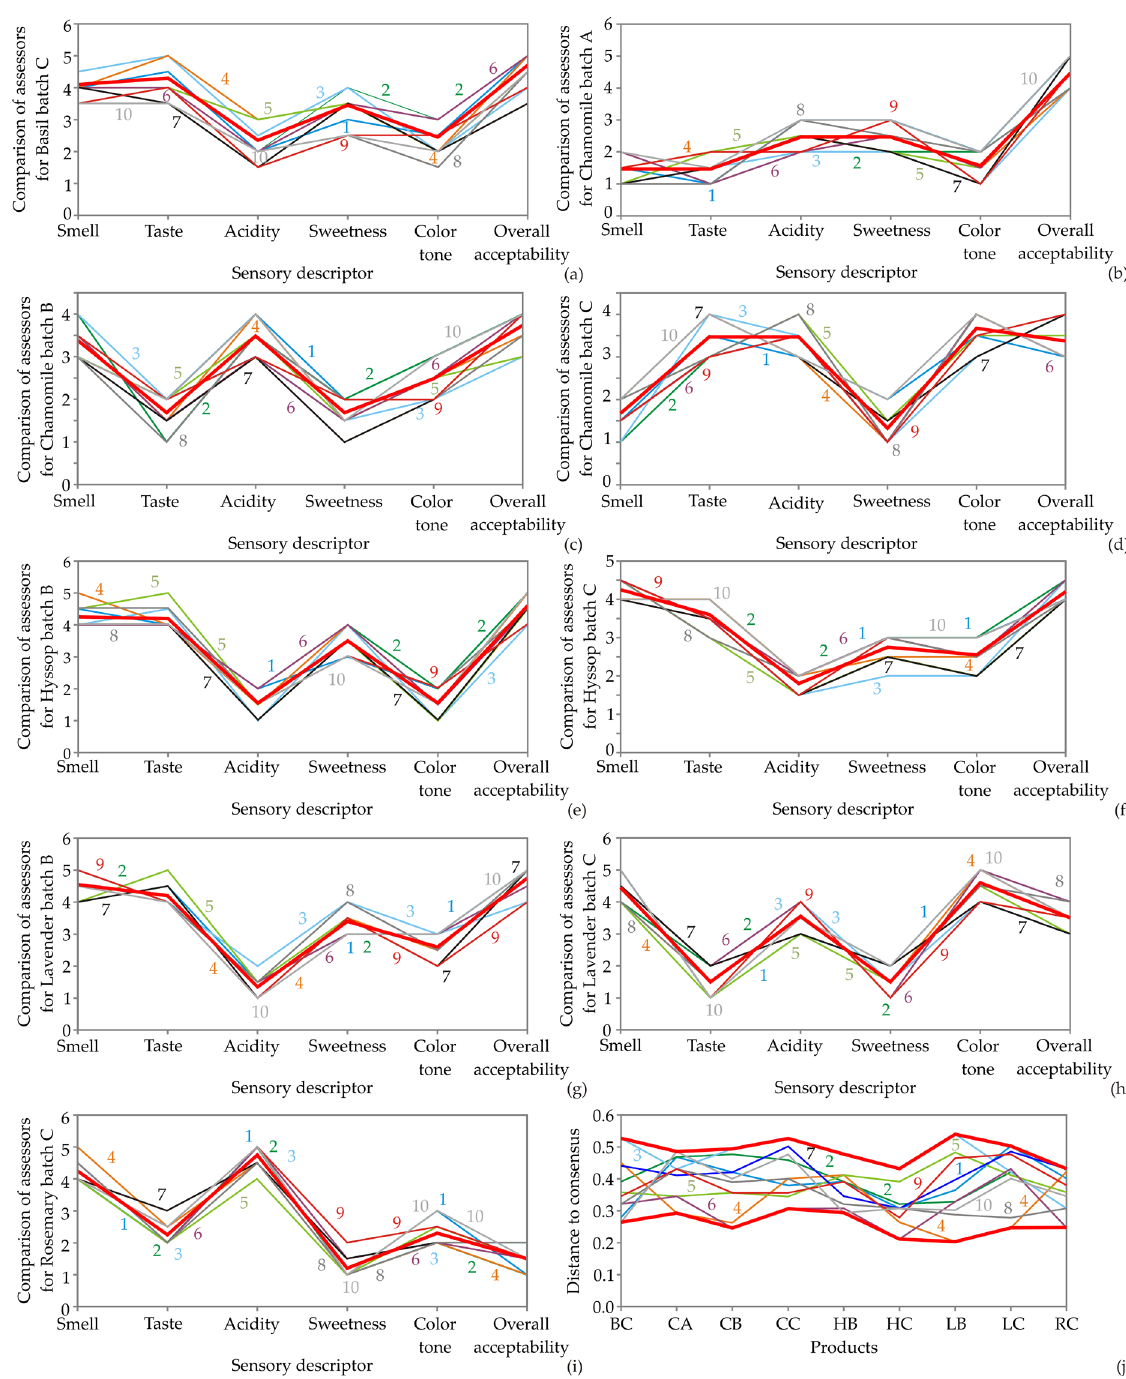
Figure 2. Sensory scores for products and assessors for a set of descriptors for ( a ) Basil batch B, ( b ) Chamomile batch A; ( c ) Chamomile batch B; ( d ) Chamomile batch C; ( e ) Hyssop batch B, ( f ) Hyssop batch C, ( g ) Lavender batch B, ( h ) Lavender batch C, ( i ) Rosemary batch C, and ( j ) Euclidean dis- tance of the assessor’s evaluation to consensus.